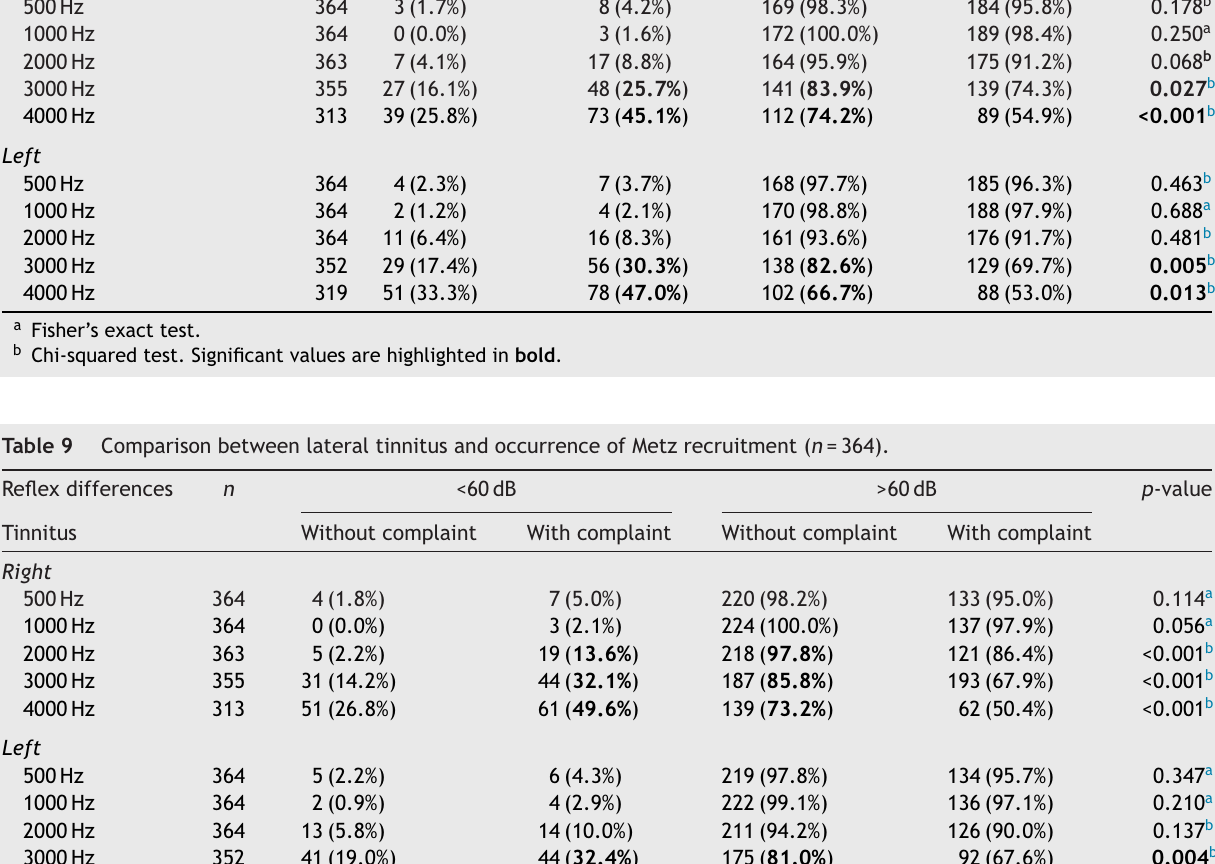
Comparison between irritation with loud sounds and occurrence of Metz recruitment. Reflex differences n Oversensitivity to loud sounds Right